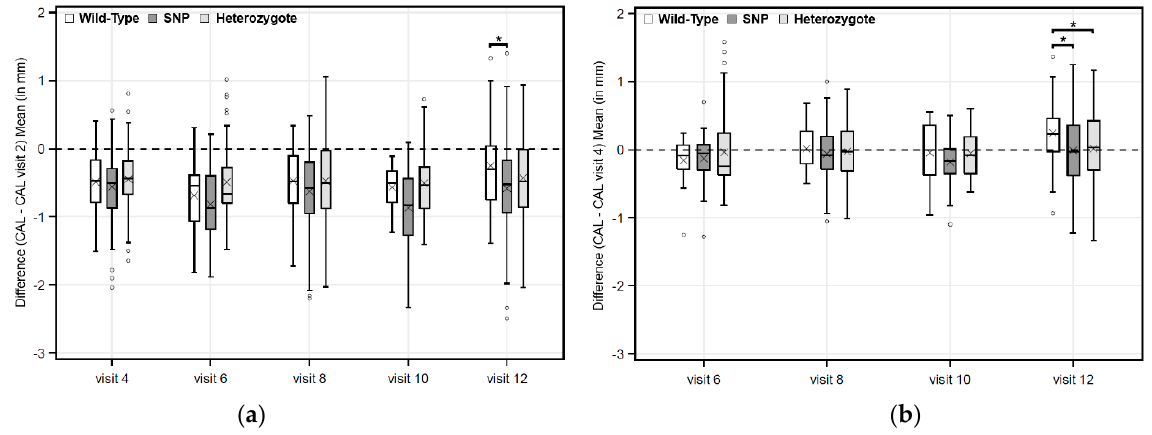
Figure 1. Boxplots of GATA-3: Mean CAL differences to visit 2 ( a ) and to visit 4 ( b ) in the total collective: * p -values are from Mann–Whitney U-tests for the pairwise comparison with the wild-type group. Negative values represent an improvement and positive values represent a deterioration. Abbreviations: CAL: mean clinical attachment level per patient, SNP: single nucleotide polymorphism, mm: millimeter, × marks the mean.